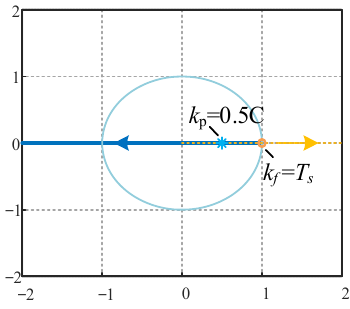
Figure 6. Zero ‐ pole plot of transfer function. Figure 6. Zero-pole plot of transfer